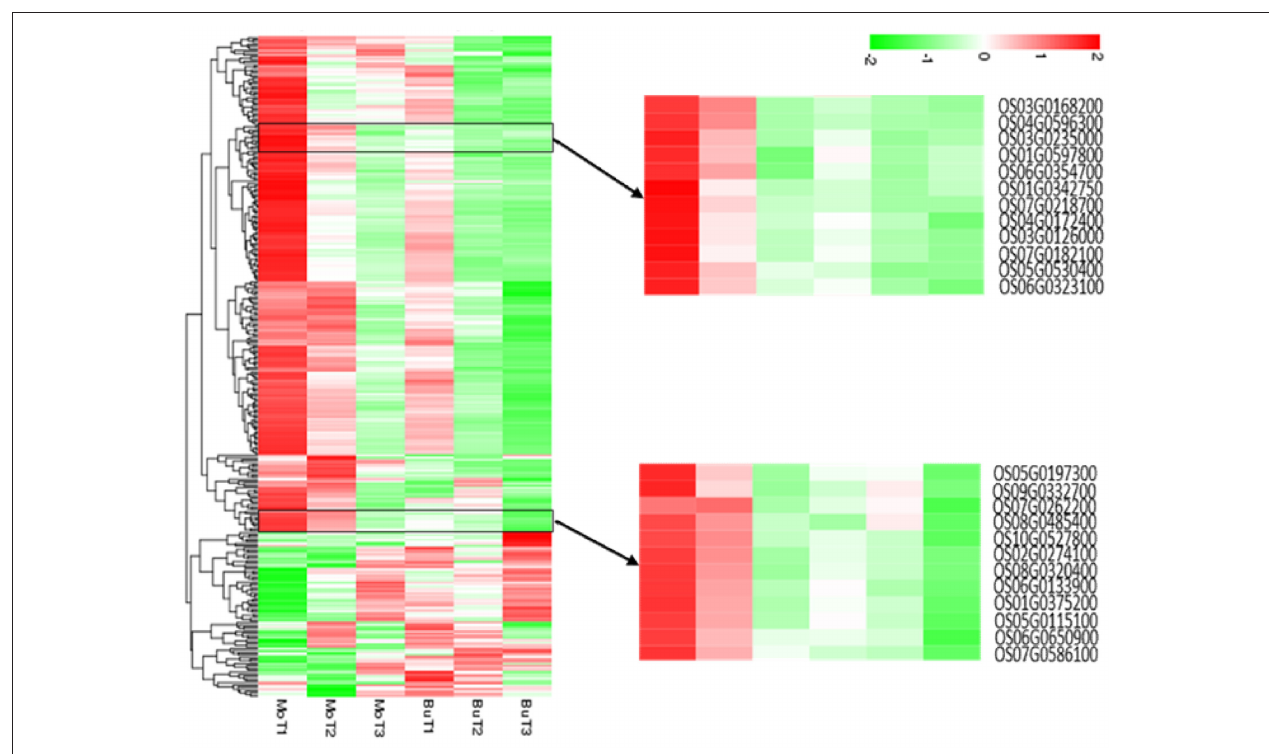
FIGURE 2 | Hierarchical clustering of the differentially expressed genes. The heat map shows the gene expression clusters and sample clusters. Each line indicates data from a single gene. The color bar represents the log 10 (RPKM) of each gene, ranging from green ( − 2) to red (2). Two detailed gene clusters show the genes that are up-regulated in the MoHrip1-treated samples after 24 and 48 h and down-regulated in the buffer-treated samples after 24, 48, and 72 h.